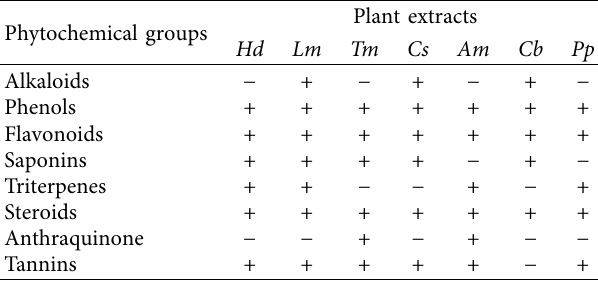
Table 2: Qualitative analysis of phytochemicals of the methanolic extracts of seven medicinal plants.